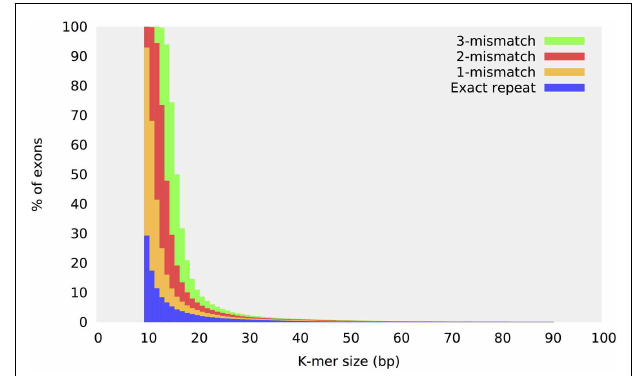
FIGURE 2 | Repeat content in the human exome . Repeat content distribution in the human exome target regions as a function of the k -mer size.The sequence of each target exon is analyzed to check for the presence of a repeat structure within the same region defining the exon.The y -axis reports the percentage of those exons that have been found to contain an identical or near-identical repeat of size k (up to three